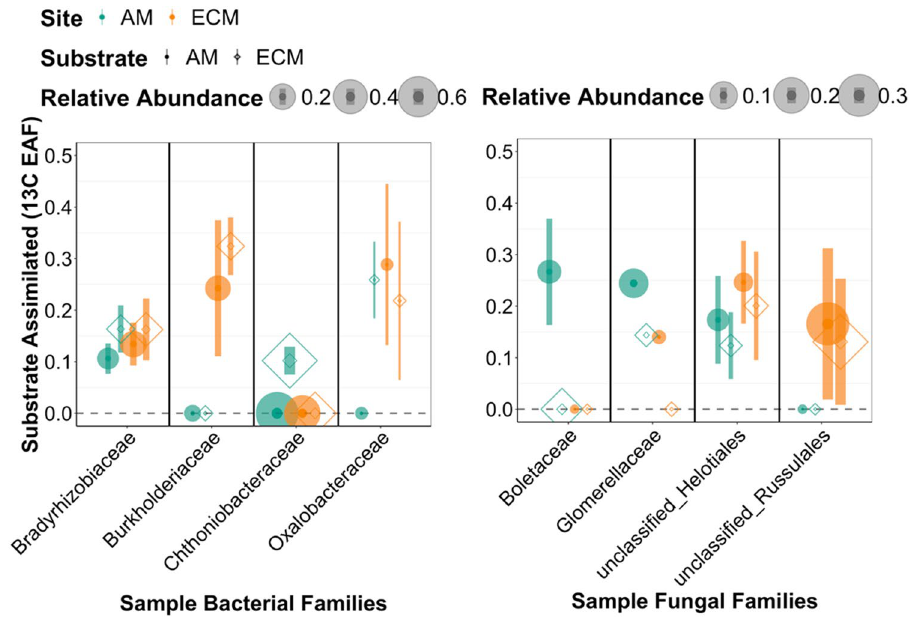
Figure 3. Example taxa illustrative of variation in substrate assimilation by soil and substrate type. Substrate assimilated is shown with sample bacterial and fungal families. Symbols represent averages and error bars show standard